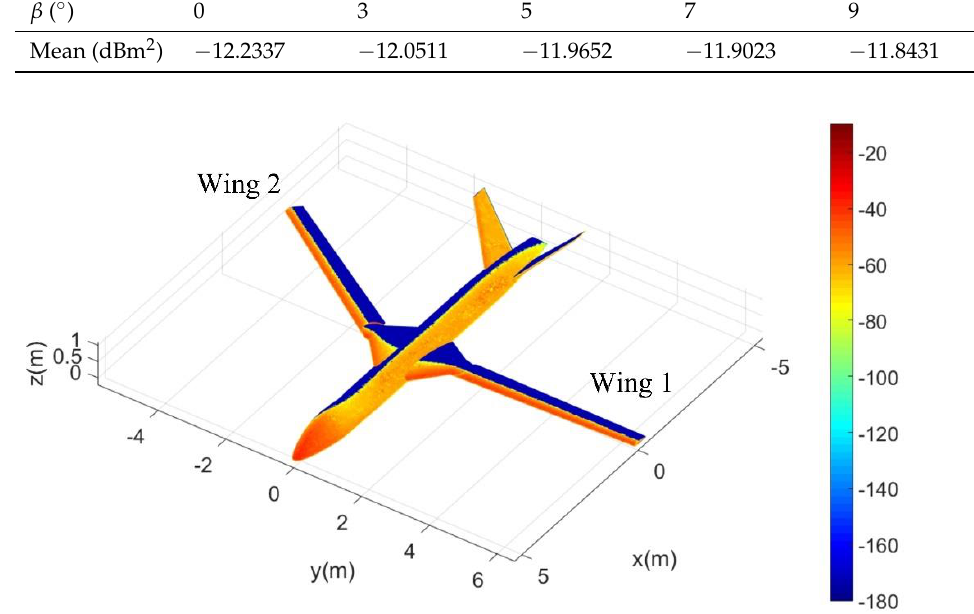
Figure 10. Surface scattering characteristics of the aircraft, where F r = 5 GHz, α = 10°, β = 2°, A s1 = 0°, and A s2 = 32°. RCS unit: dBm 2 .